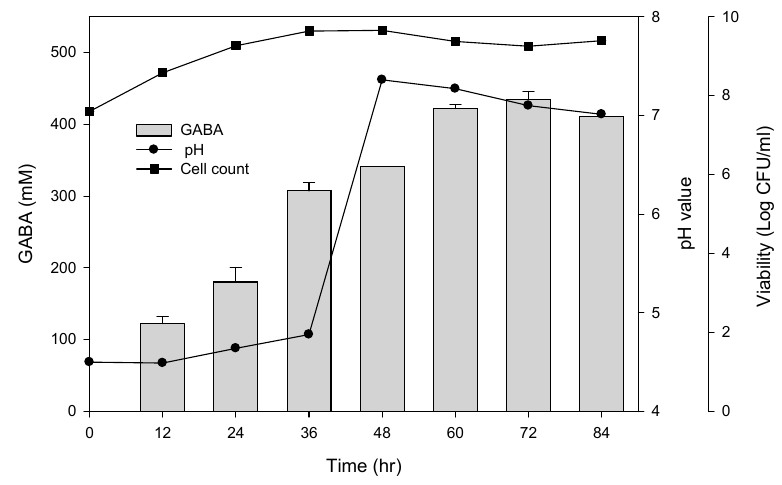
Figure 4. Effects of single hydrogel (sample H) biofilm formation on GABA production and pH values. ( ● ) pH value; ( ■ ) cell count: log CFU /mL. Grey bars represent GABA concentrations.